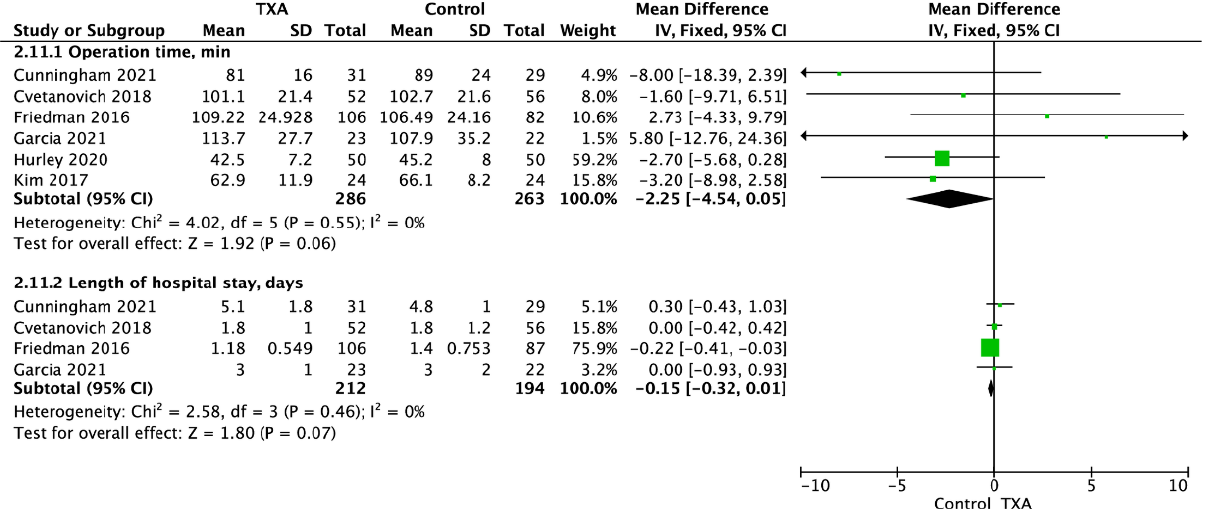
Figure 3. Forest plot of ( 2.11.1 ) operation time; ( 2.11.2 ) length of hospital stay among TXA and non-TXA groups. The centre of each square represents the weighted mean differences for individual trials, and the corresponding horizontal line stands for a 95% confidence interval. The diamonds represent pooled